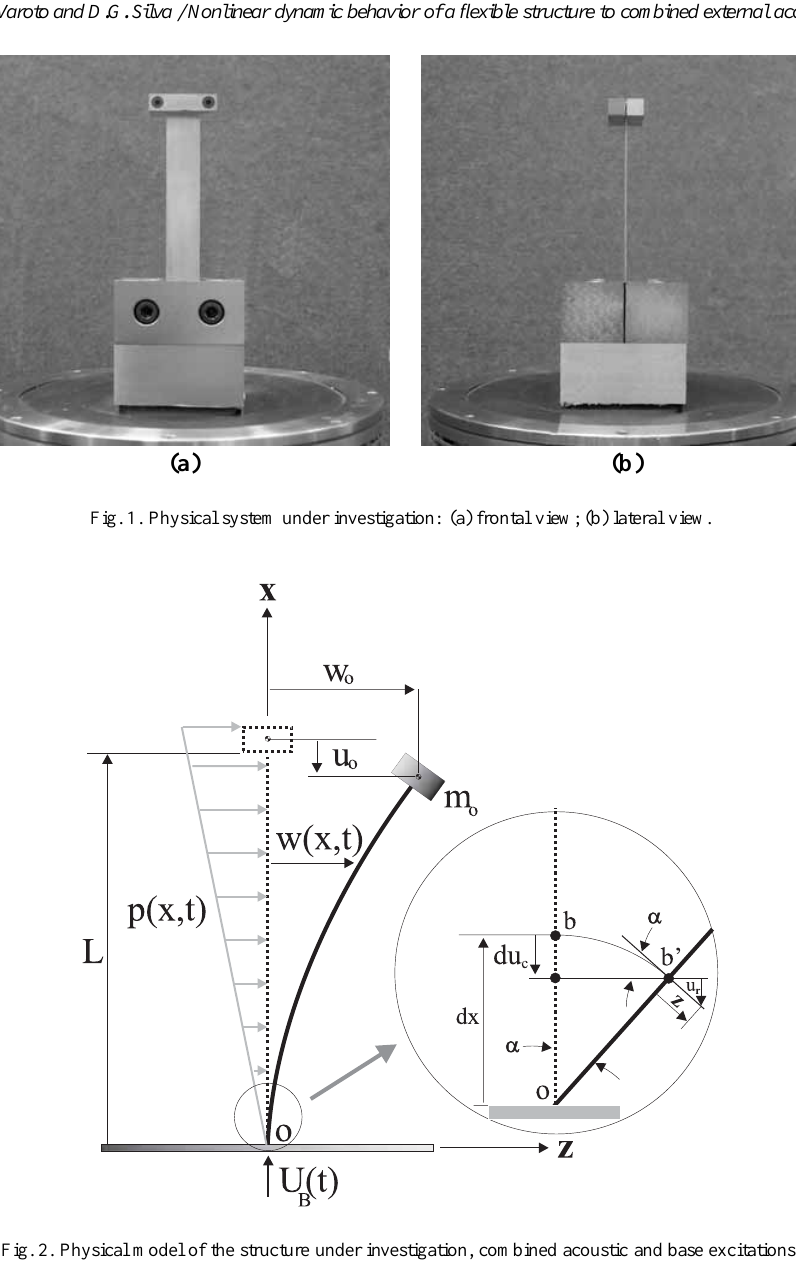
Fig. 2. Physical model of the structure under investigation, combined acoustic and base